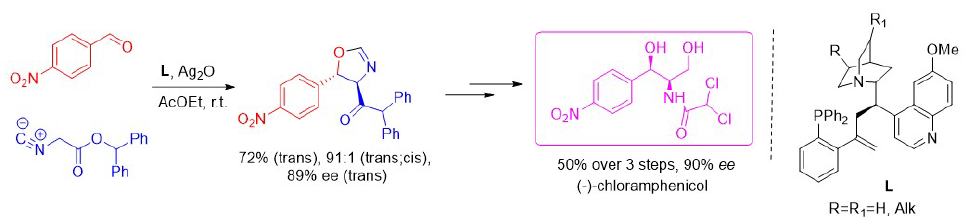
dantrolene *- see Table 1 Scheme 4. Synthesis of dantrolene. Table 1. Reagents and conditions. *